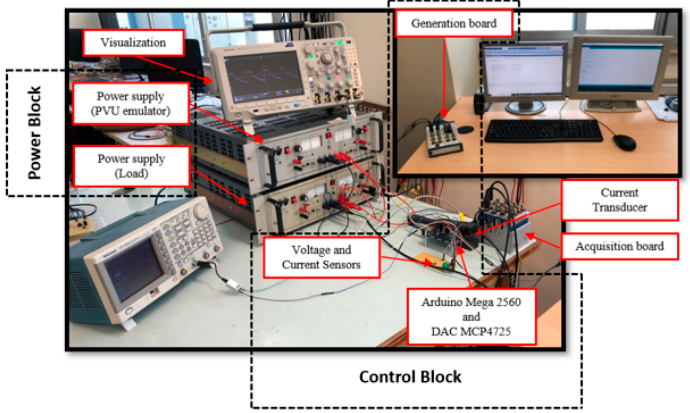
Figure 13. Experimental setup of proposed Boost based PVU emulator.